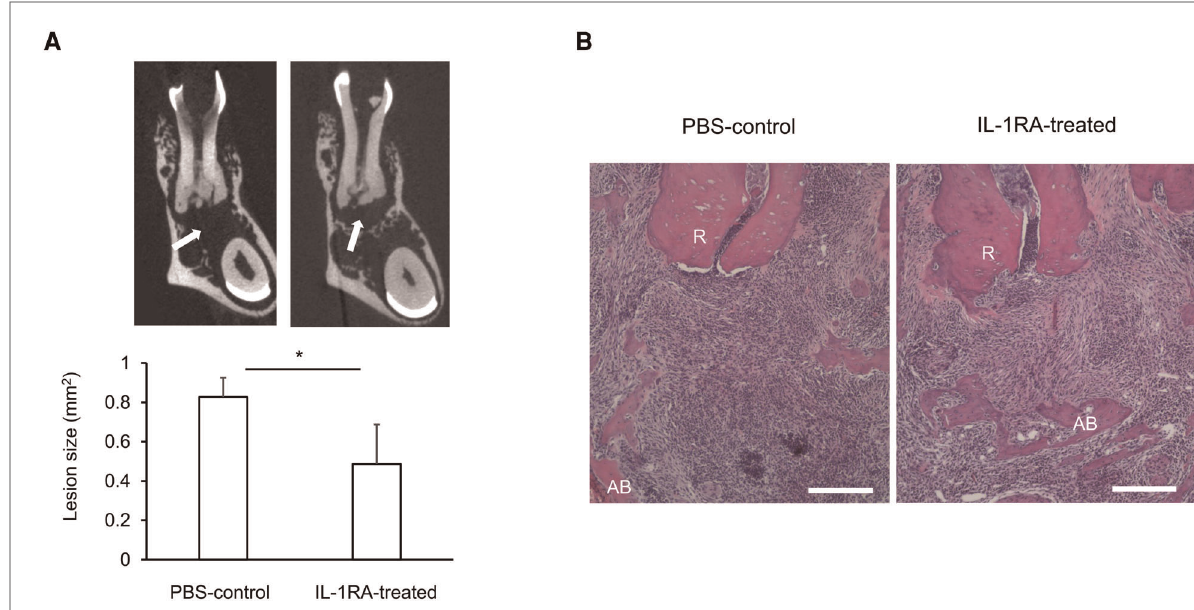
FIGURE 1 ( A ) Representative microCT images and periapical lesion size in phosphate buffered saline (PBS)-control and IL-1RA administration on day 42 after endodontic infection. Values are mean and SD; * p <0.05. Arrow: periapical lesion. ( B ) Histology of periapical lesions on day 42 after endodontic infection. Representative images of hematoxylin and eosin (HE) staining for each group are shown. PBS, phosphate buffered saline; AB, alveolar bone; R, dental root; Scale bars=200